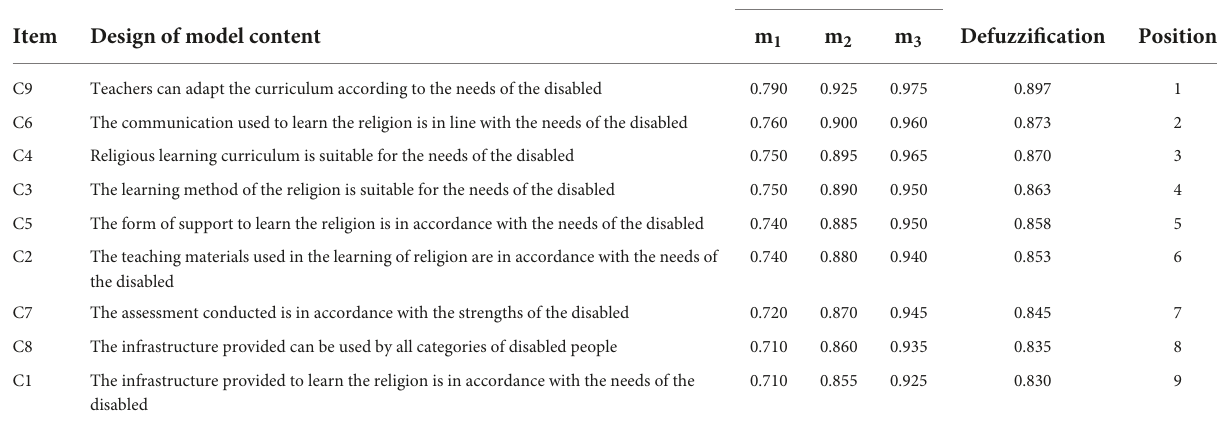
TABLE 7 Fuzzy evaluation on construct three: Universal design learning for children with learning disabilities.